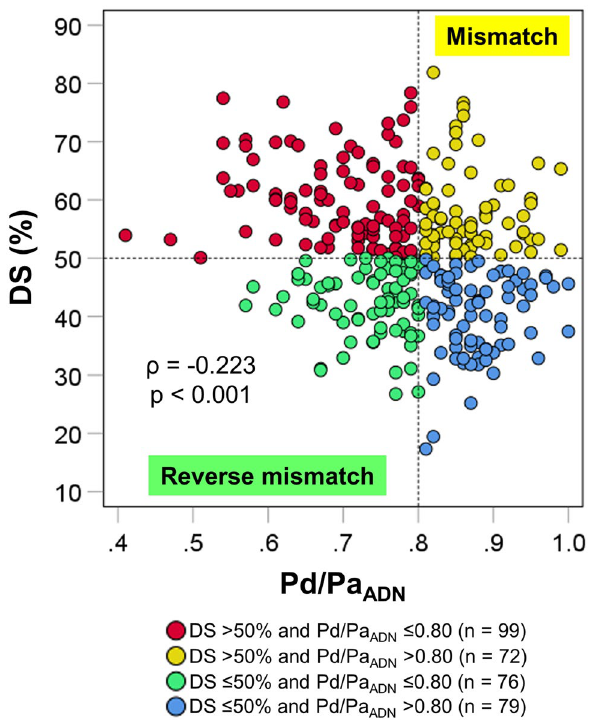
Figure 1. Scatter plot of DS and Pd/Pa ADN The anatomical ‒ functional mismatch was defined as DS > 50% and Pd/Pa ADN > 0.80, and the reverse mismatch as DS > 50% and Pd/Pa ADN ≤ 0.80. DS diameter stenosis, and Pd/ Pa ADN distal-to-aortic pressure ratio associated with